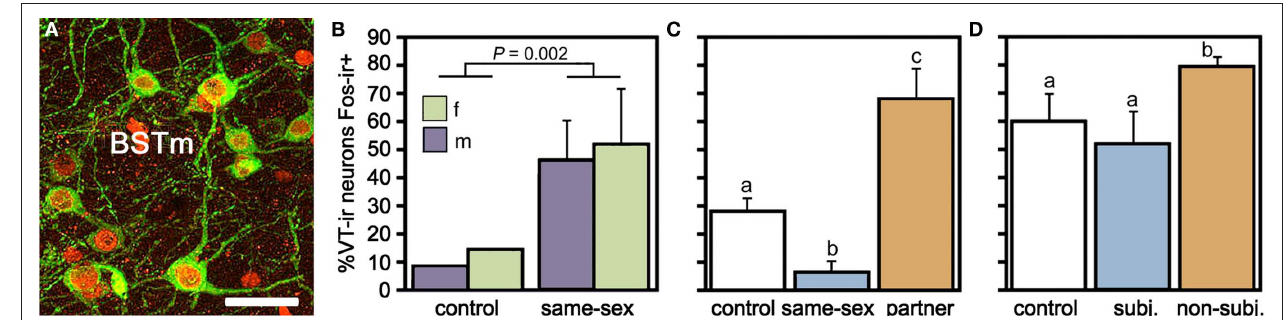
not naturally exhibit same-sex affiliation, but exposure to the subject’s pairbond partner (a presumably positive stimulus), produces a robust increase in neuronal activity. Sexes are shown pooled. Total n = 16. (D) VT–Fos colocalization increases in zebra finches following competition with a same-sex individual for courtship access to an opposite-sex bird, but not if the subject is paired with a highly aggressive partner and intensely subjugated. Subjugated animals were aggressively displaced or attacked 71–210 times during a 10-min interaction, demonstrating that social arousal alone does not increase VT–Fos colocalization in the BSTm. Sexes are shown pooled. Total n = 15. (A) is modified from Goodson et al. (2009b); (B–D) are modified from Goodson and Wang